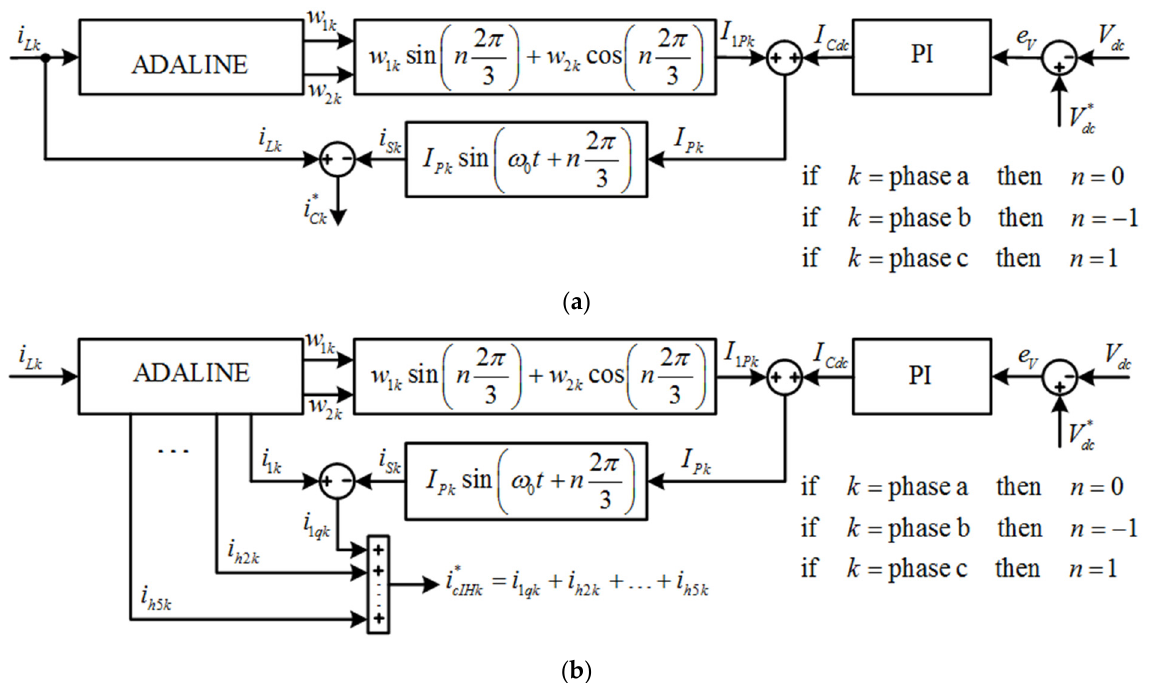
Figure 5. ADALINE harmonic detection and power factor (PF) improvement: ( a ) The harmonic detection process for harmonic current elimination; ( b ) The harmonic detection process for the individual harmonic components.